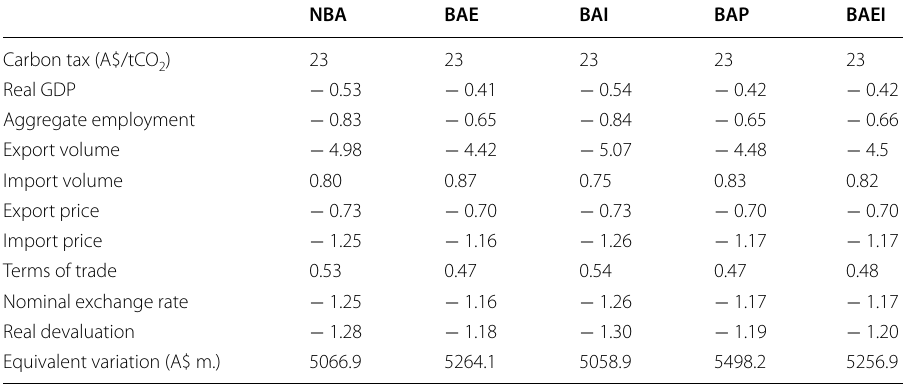
Table 3 Key macroeconomic and trade results from the simulations. Source Model simula-